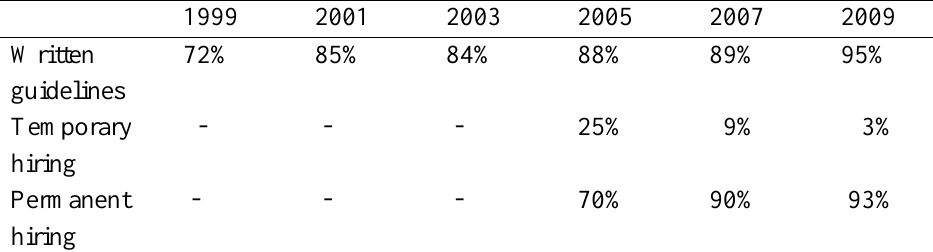
Formalization of management